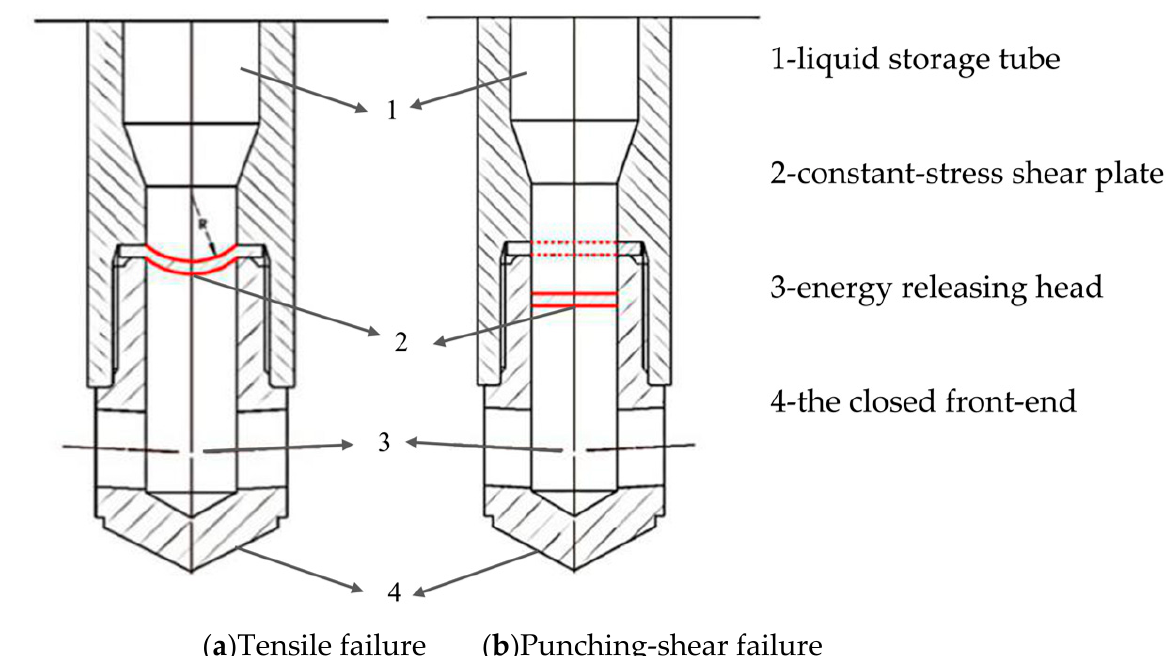
Figure 9. Schematic diagram of two different failure mode of constant-stress shear plates.